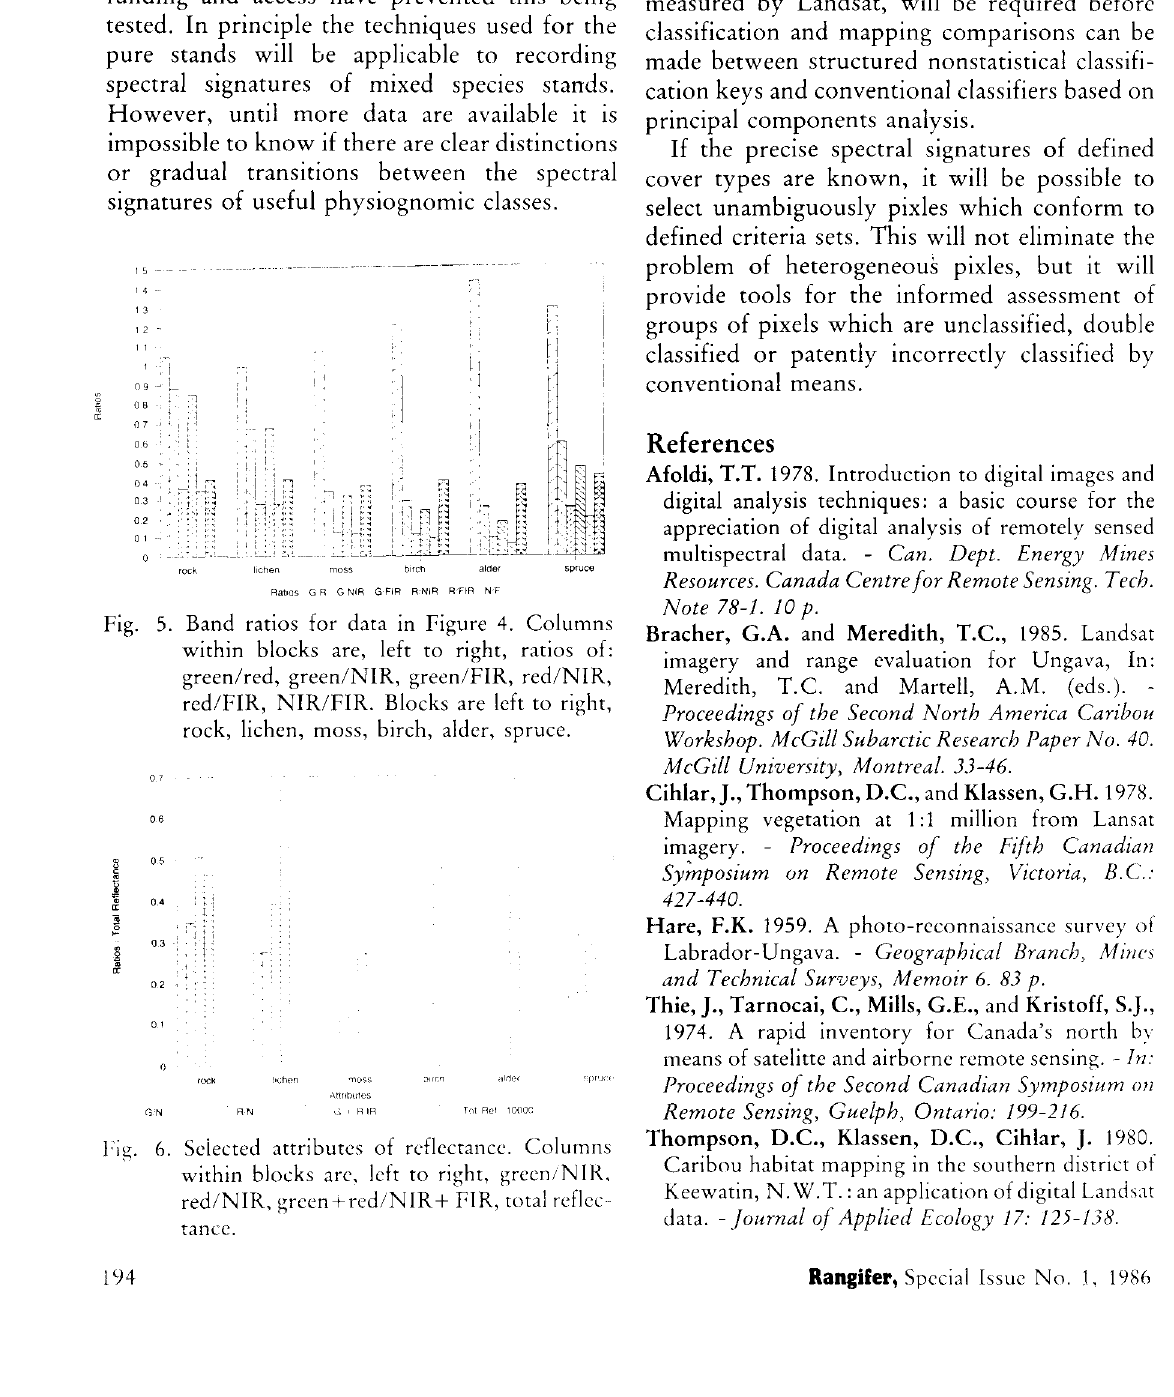
6. Selected attributes of reflectance. Columns within blocks are, left to right, green/NIR, red/NIR, green + red/NIR + FIR, total reflec